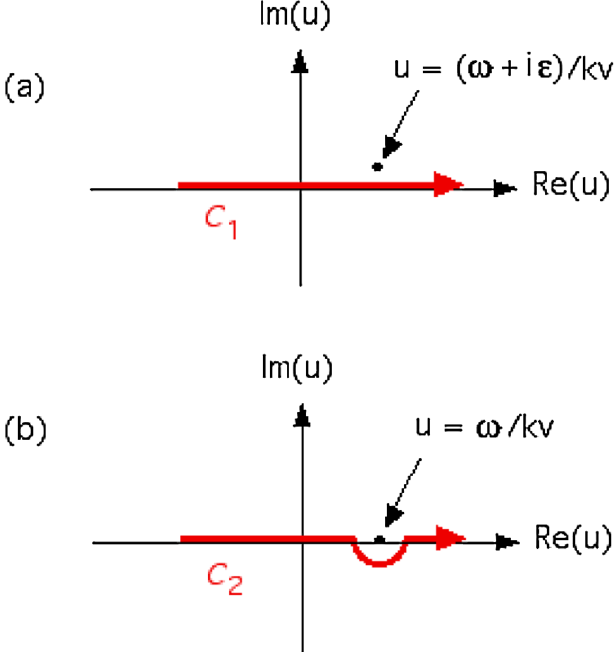
FIG. 1. (Color) Integration contour dictated by Landau damping analysis. The quantity (cid:5) in (a) and the radius of the semicircle in (b) are considered to be